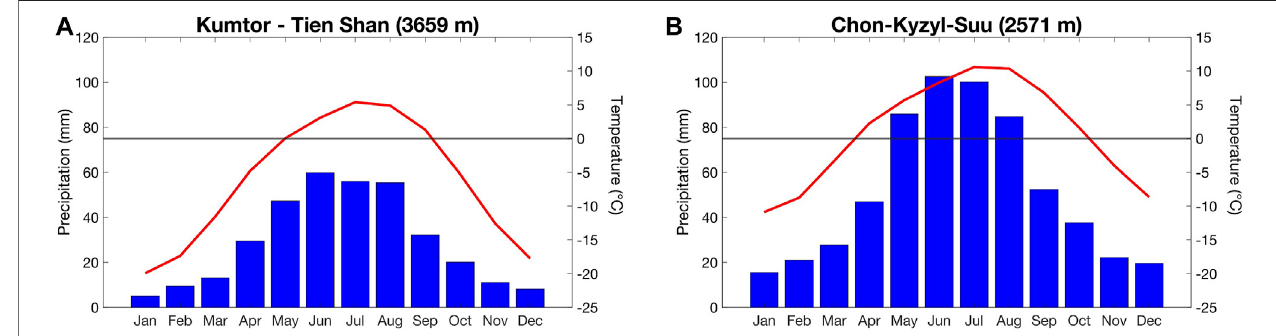
FIGURE 4 | Climate diagram of Kumtor – Tien Shan (A) and Chon-Kyzyl-Suu (B) for the period 1991 – 2020.